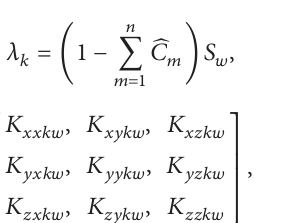
Table 1: Parameters of the numerical